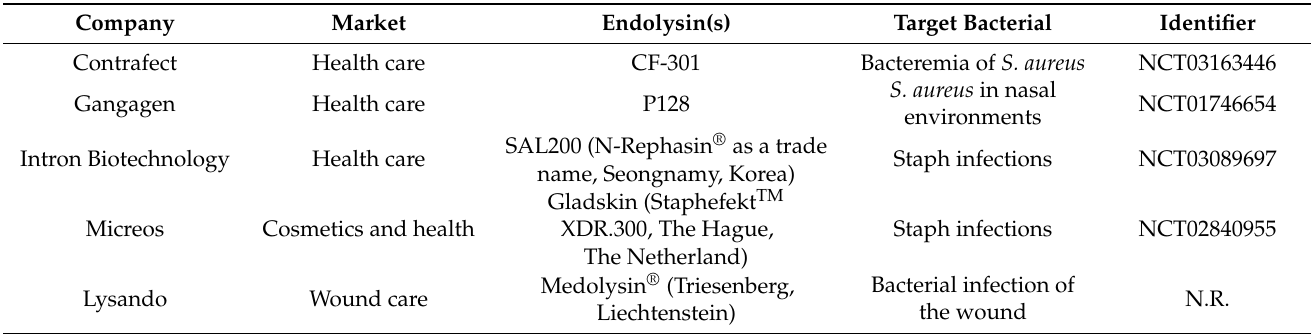
Table 4. Commercial endolysins and their respective manufacturing